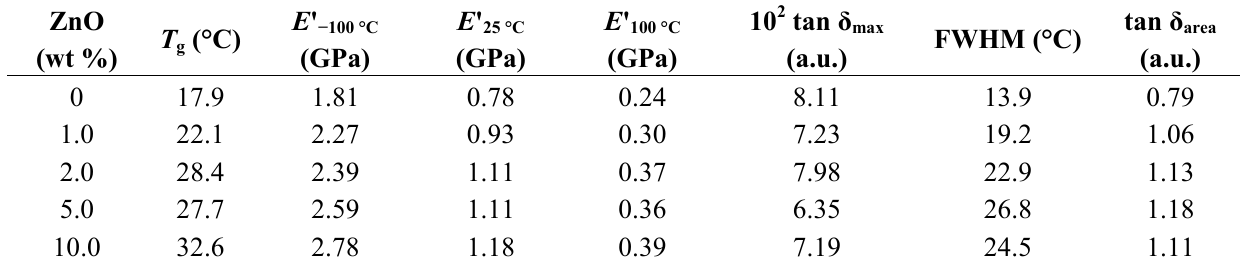
Table 2. DMA data for neat PHB and the nanocomposites with different ZnO loadings. ZnO